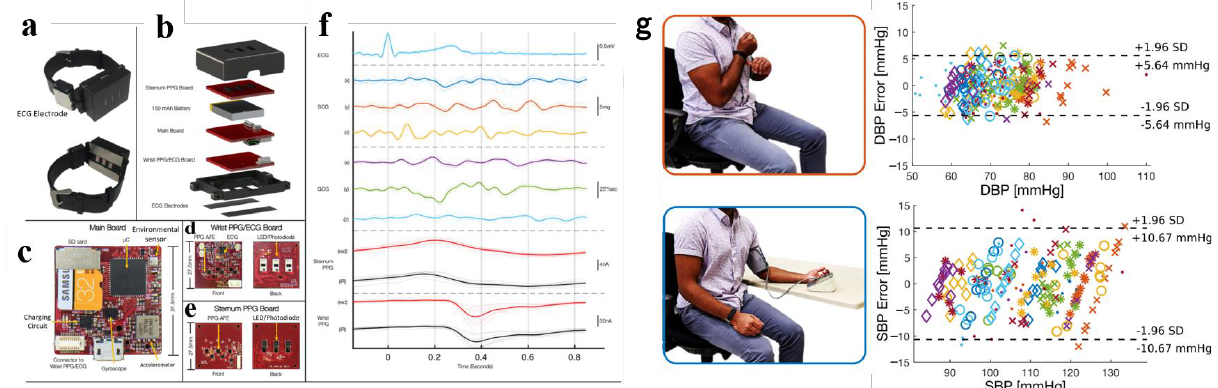
Figure 8. ( a ) The shape of the watch; ( b ) The components of the watch; ( c ) Main board; ( d ) The wrist PPG/ECG board; ( e ) Sternum PPG board; ( f ) Ensemble averaged waveforms from a single 30 s recording; ( g ) Experimental setup and data analysis. Reproduced with the permission of [66]. Copyright 2021, IEEE.